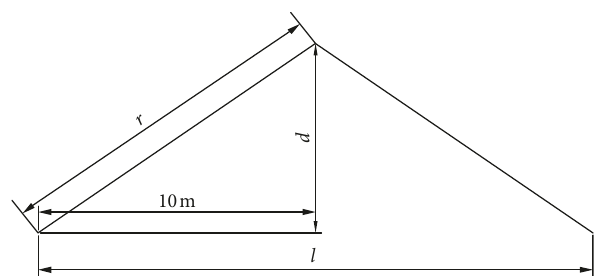
Figure 11: Fractal graphics of “deep-shallow-fractal” blasting layout. Table 4: Fractal dimensions of the different blasting layouts. “Straight- “Triangular- “Deep-shallow- Blasting layout line” fractal”